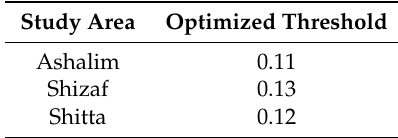
Table 2. Optimal threshold values for each study